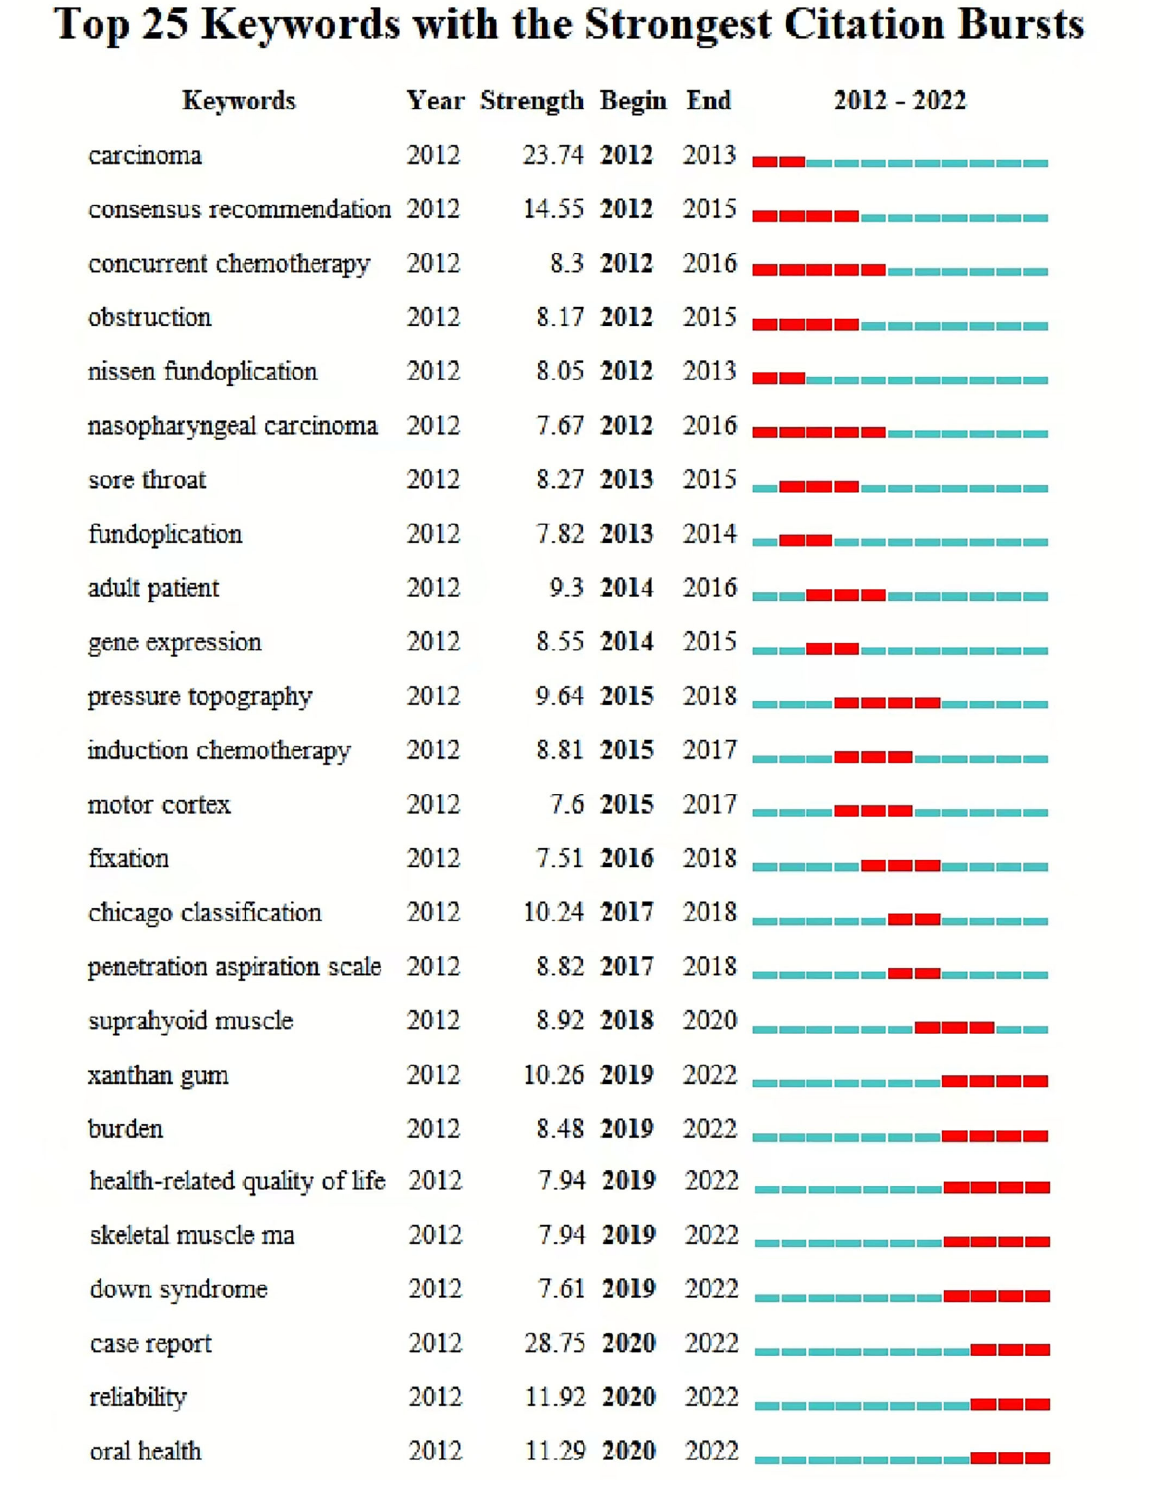
FIGURE10 Top 25 keywords with the strongest citation bursts in published articles on dysphagia from 2012 to 2022. The timeline is depicted as a blue line, and the time interval that a subject was found to have a burst is shown as a red segment which indicated the beginning year, the ending year, and the duration of the